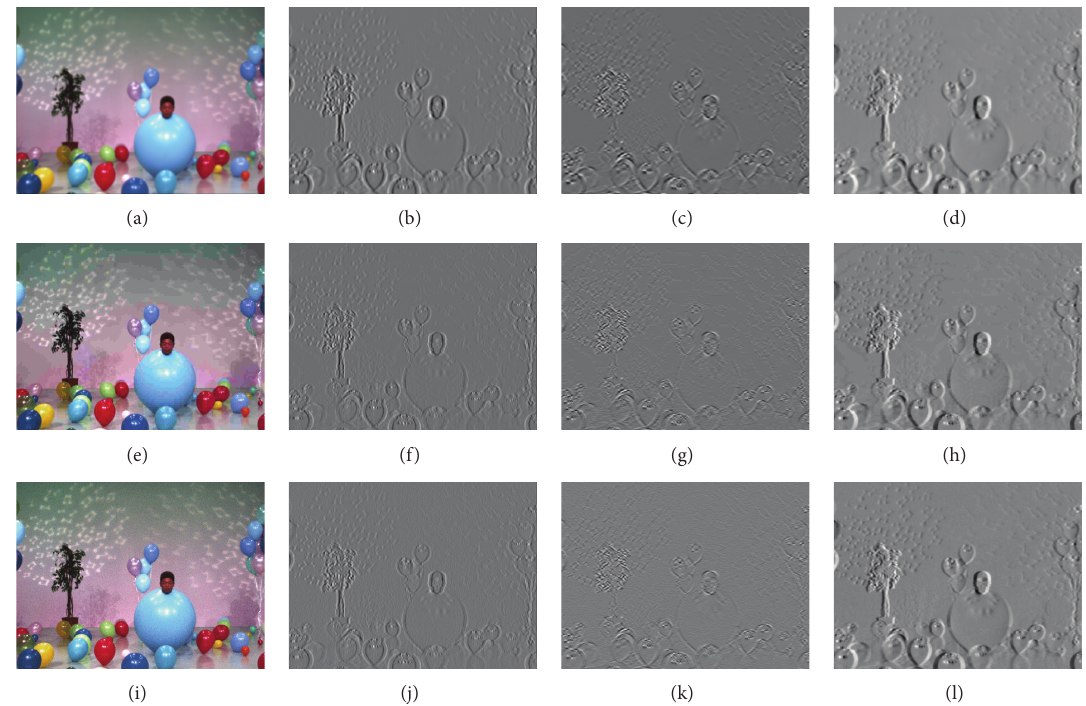
Figure 3: Examples of quality degraded left images and the corresponding gradient maps of “Balloons” test sequence. (a) ∼ (d): (a) Gaussian blurred image; (b) horizontal gradient map of (a); (c) vertical gradient map of (a); (d) viewpoint gradient map of (a). DMOS = 29.435, 3D- GMS = 0.9720; (d) ∼ (g): (e) JPEG compressed image; (f) horizontal gradient map of (e); (g) vertical gradient map of (e); (h) viewpoint gradient map of (e). DMOS = 30.609, 3D-GMS = 0.9803; (i) ∼ (l): (i) WN distorted image; (j) horizontal gradient map of (i); (k) vertical gradient map of (i); (l) viewpoint gradient map of (i). DMOS = 30.130, 3D-GMS =